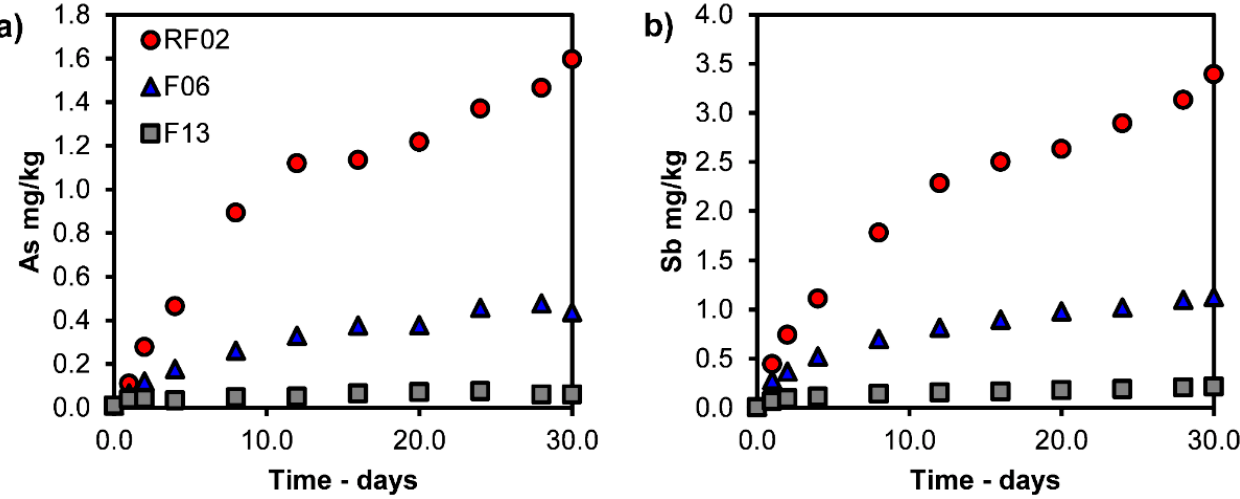
Figure 6. Leaching of ( a ) As and ( b ) Sb (mg/kg) versus time from dynamic leaching tests. Table 2. Dynamic leaching data of leachates in the reactor and boiler after leaching for 30 days. Reactor Sample